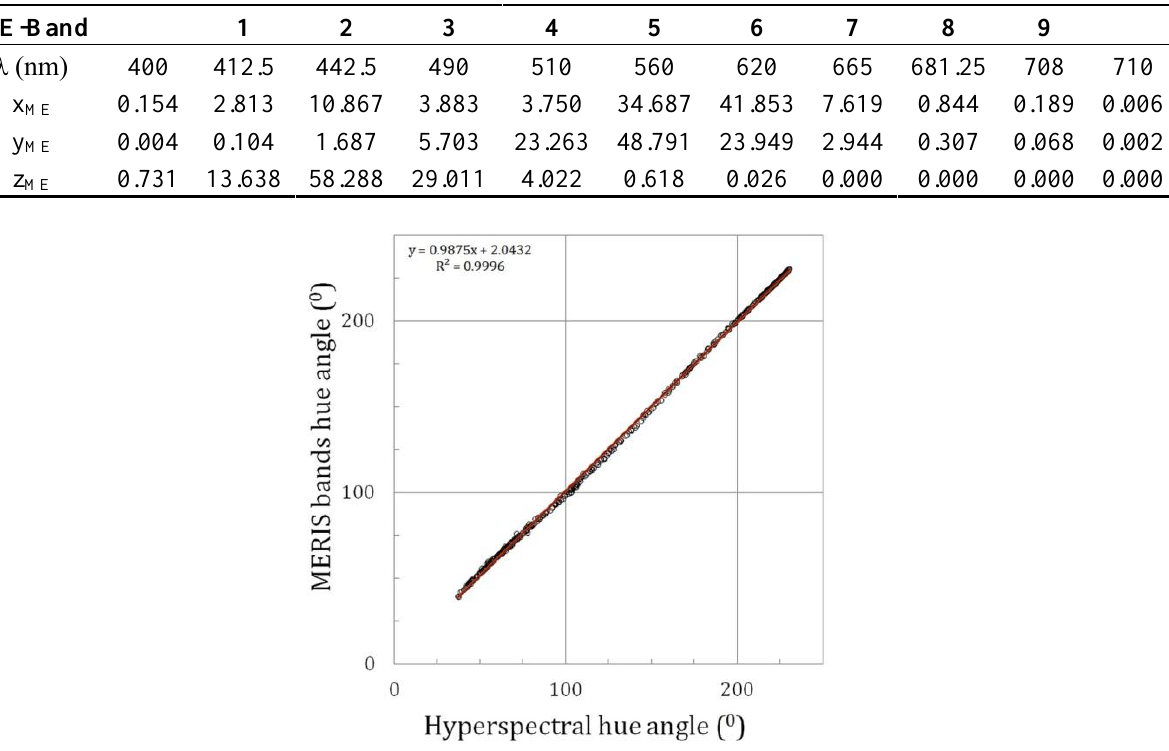
Table 2. Linear coefficients to calculate the chromaticity values based on MERIS bands.